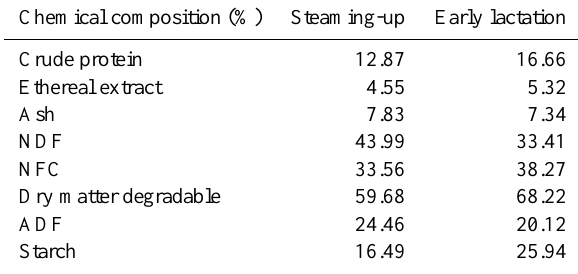
Table 1. Chemical composition of diets used during steaming-up and subsequent early